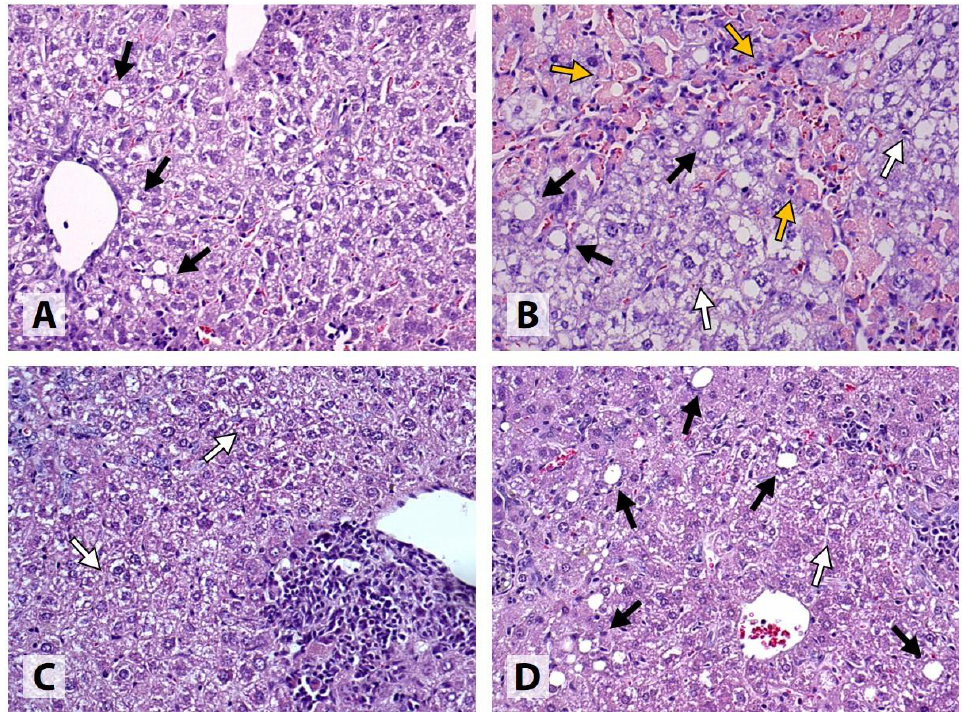
Figure 3. Liver histology (hematoxylin and eosin stain, × 200). ( A ) Intact: moderate cholestatic granulomatous hepatitis; mild medio- and macrovesicular steatosis (black arrows). ( B ) Control: severe cholestatic hepatitis complicated by extensive centrilobular and bridging necrosis (yellow arrows); mild medio- and macrovesicular steatosis (black arrows); severe hepatocyte ballooning (white arrows). ( C ) LOLA: moderate cholestatic granulomatous hepatitis; mild hepatocyte ballooning (white arrows). ( D ) EMPA: moderate cholestatic granulomatous hepatitis; moderate medio- and macrovesicular steatosis (black arrows); mild hepatocyte ballooning (white arrow).